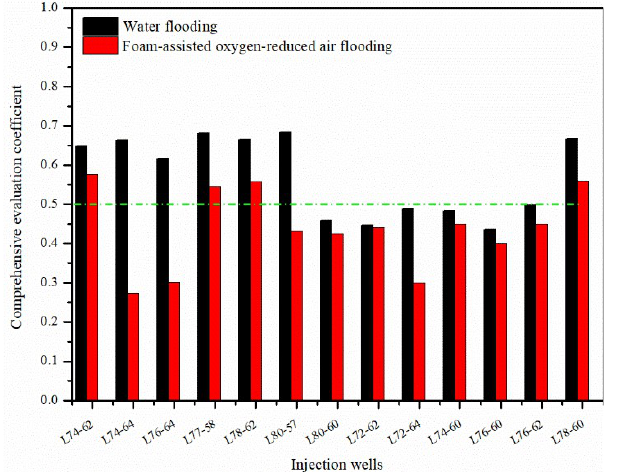
Figure 3. Identification results of the channeling channels of injection wells in the water flooding and FAORAF stages.